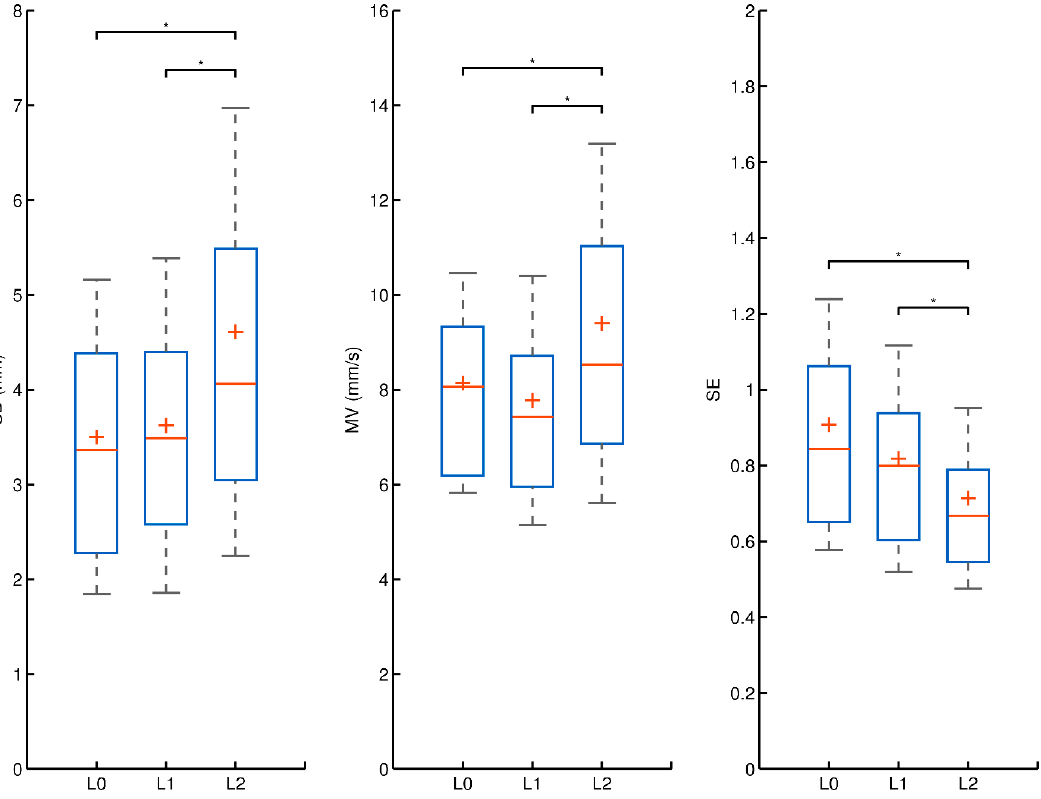
Figure 1. Main effects and significant post hoc tests. Note: +, sample mean; horizontal line, sample median; upper side of rectangle, 75% of data (upper quartile); lower side of rectangle, 25% of data (lower quartile); whiskers, mean ± standard deviation.